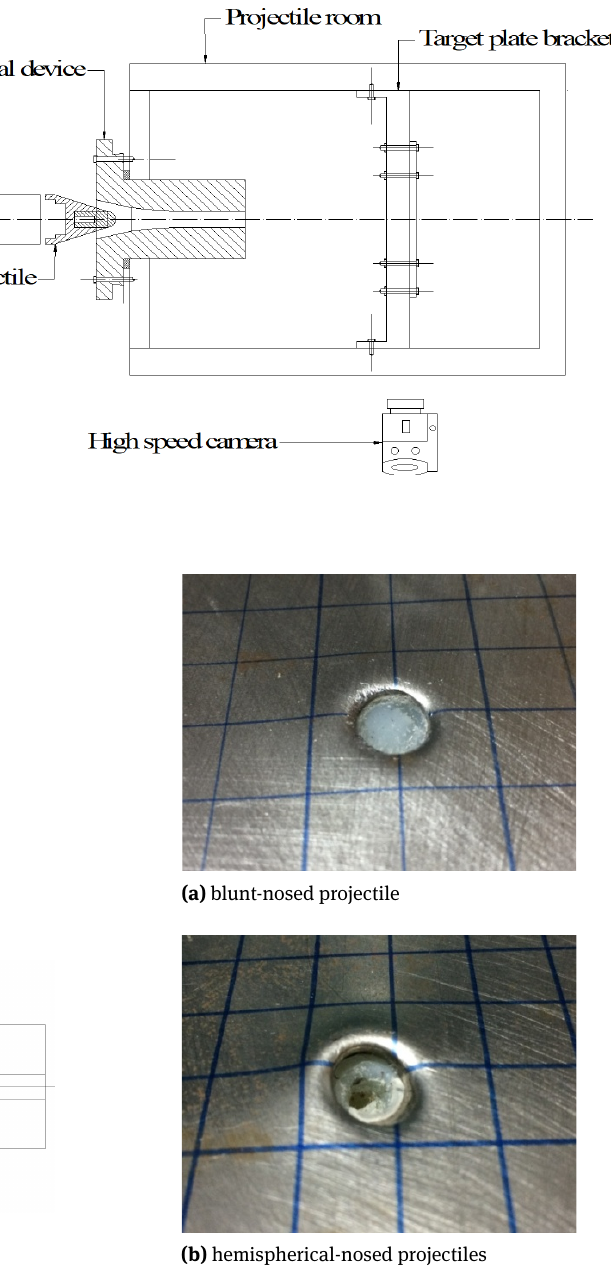
Figure 7: Failure patterns of sandwich plates obliquely impacted by